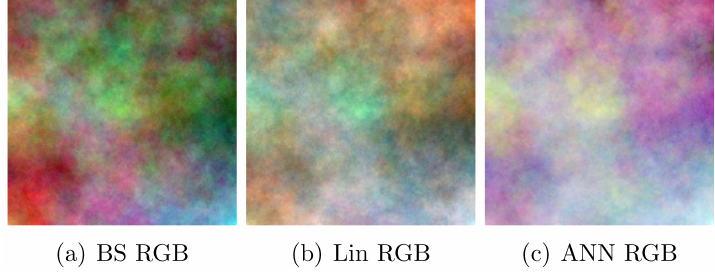
Figure 6. The RGB color composite images of the MSFI in Figure 4b.